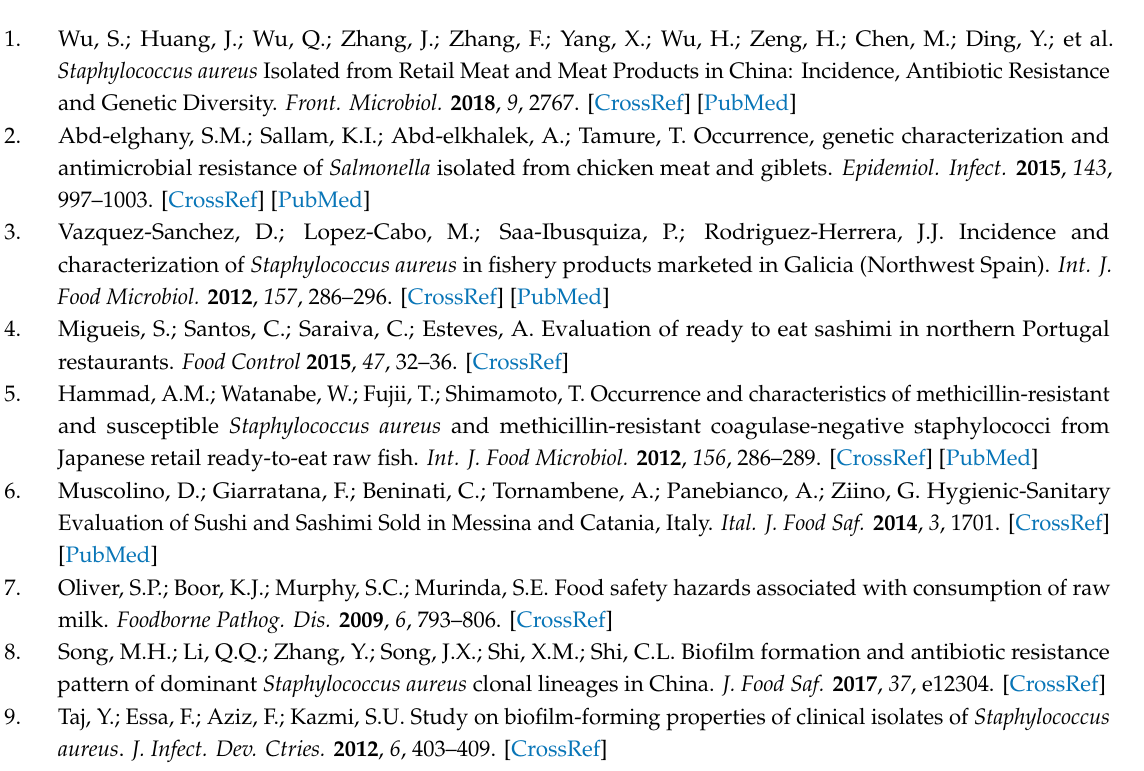
Figure S1. PCR amplification for the detection of fnbA , fnbB, and clfB gene of S. aureus isolates. Figure S2. PCR amplification for the detection of seo , sek , sei , seb , sea , cna , seu, and see genes of S. aureus isolates. Figure S3. PCR amplification for the detection of bap , sej, and sen genes of S. aureus isolates. Figure S4. PCR amplification for the detection of sec , seh , seg , tsst, and ser genes of S. aureus isolates. Figure S5. PCR amplification for the detection of sel , sed , icaD , seq, and sem gene of S. aureus isolates. Table S1: Primers used in this